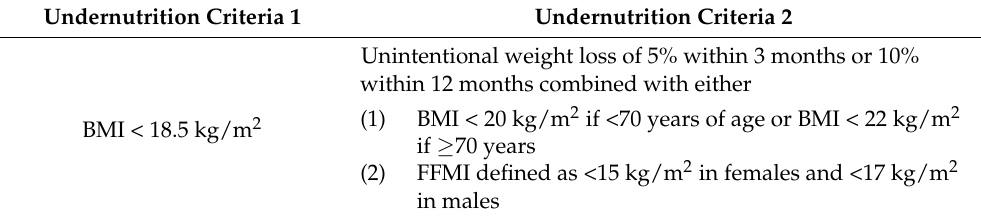
FFMI defined as <15 kg/m 2 in females and <17 kg/m 2 in